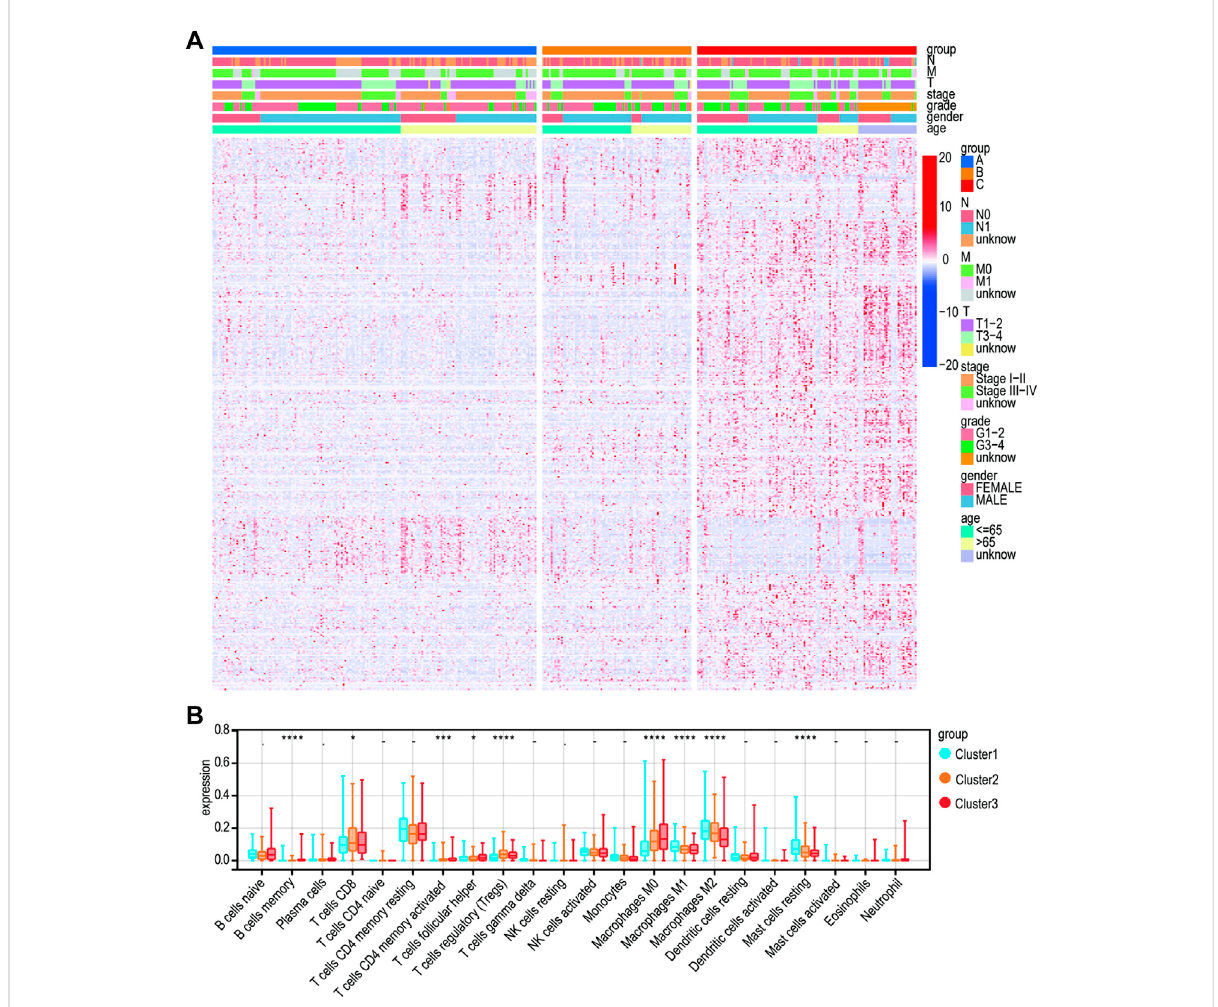
FIGURE 4 Clinical characteristics of the three subtypes. (A) Heatmap for the lactate lncRNA prognostic signature and clinicalpathological manifestations. (B) CIBERSORT for three subtypes.